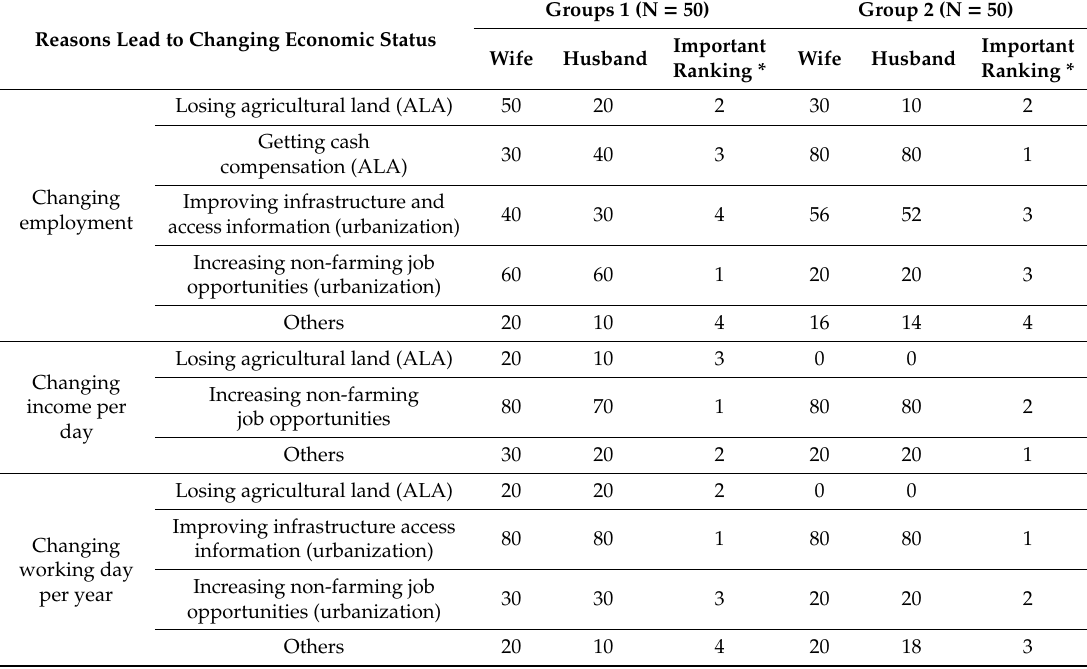
Table 3. Reasons for changing employment and income (Percentage of